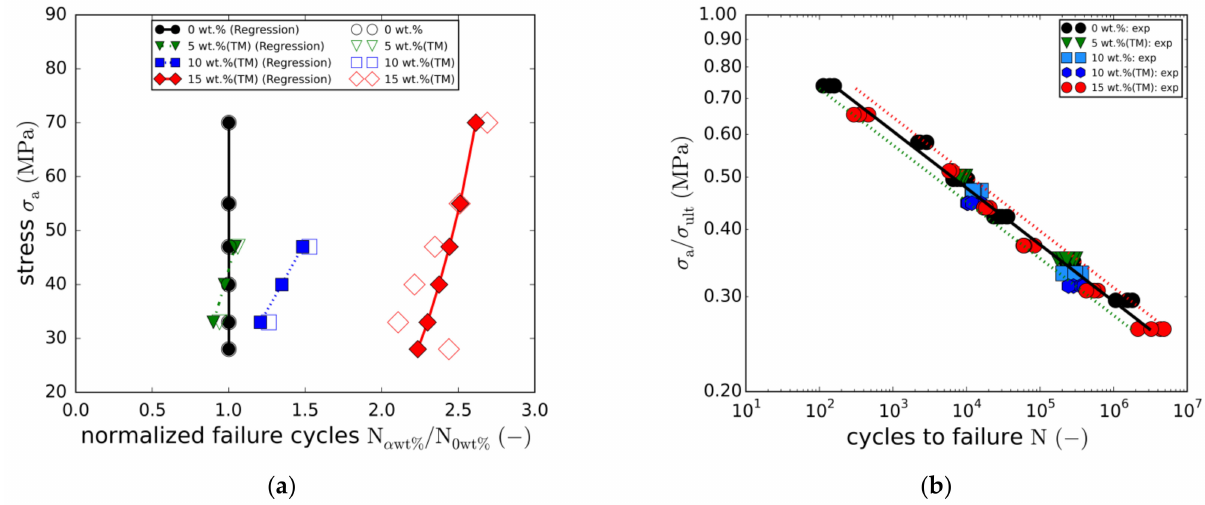
Figure 9. ( a ) Fatigue life multiplication factors in dependence of the load level; ( b ) Master S-N